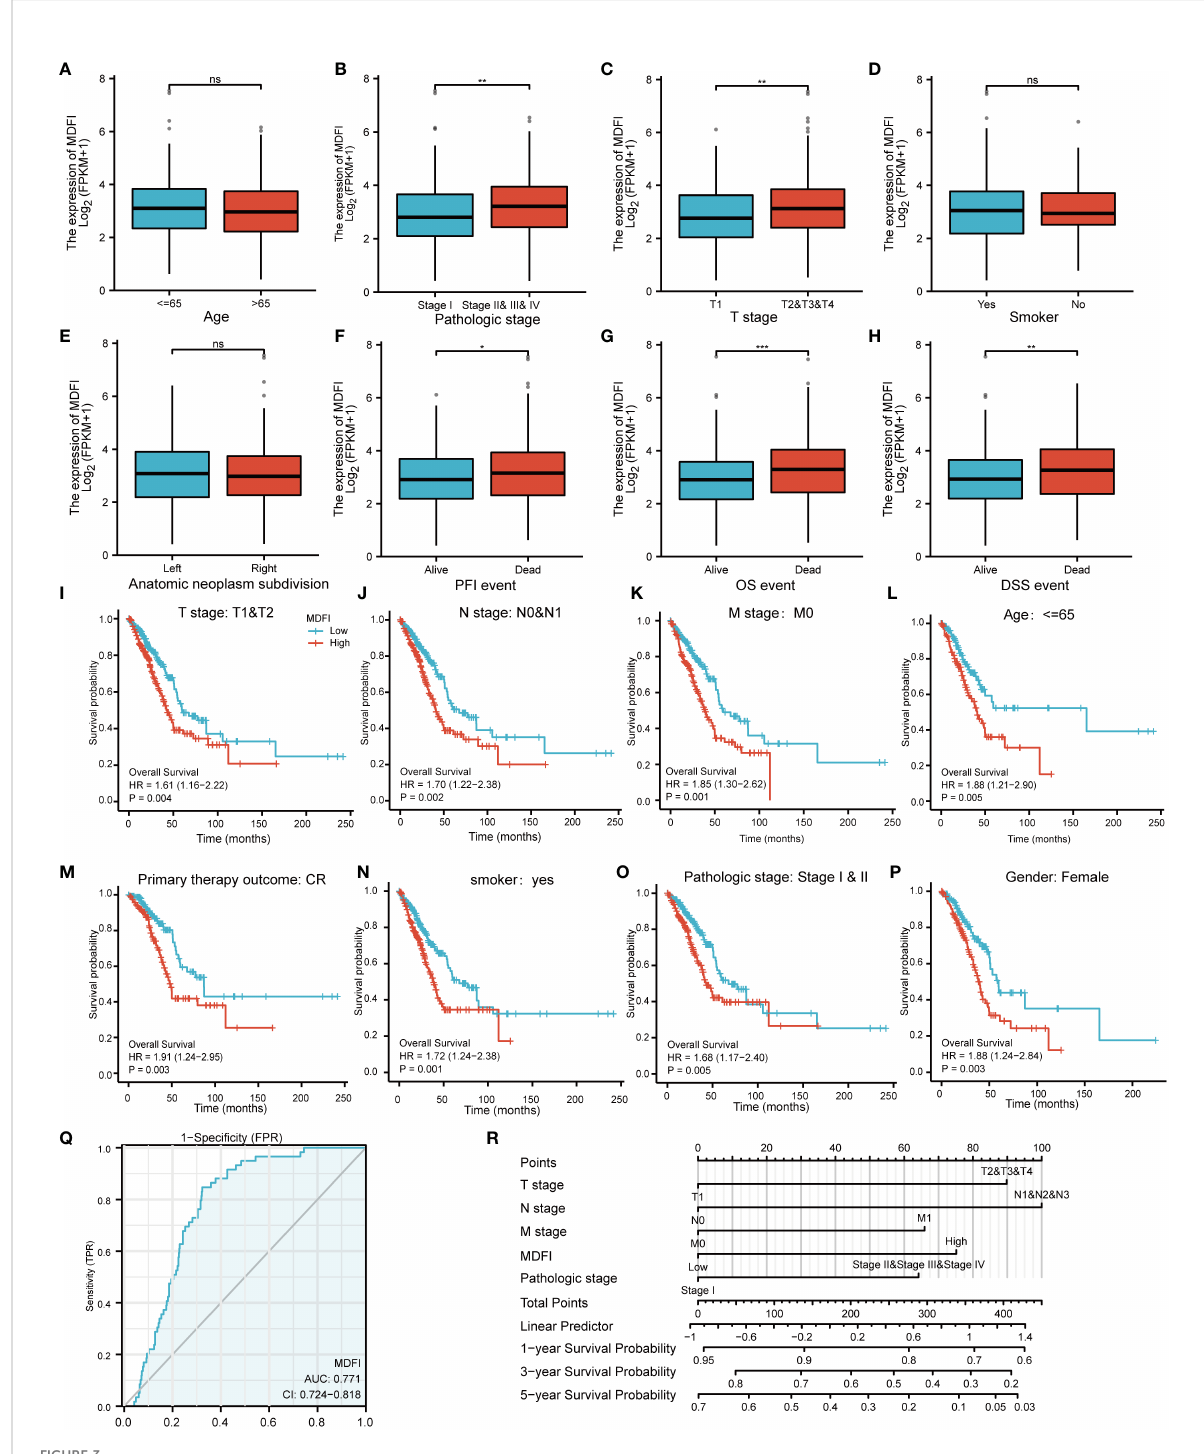
FIGURE 3 Association of MDFI expression with different LUAD characteristics and prognosis, date from TCGA, (A – H) Expression of MDFI in relation to different characteristics of LUAD, (I – P) Association between high MDFI expression in prognosis of LUAD with different characteristics, (Q) MDFI ’ s ROC curve analysis at LUAD, (R) Construction of a nomogram to assess the prognostic value of MDFI in LUAD. *p < 0.05, **p < 0.01, ***p < 0.001, ns, p > 0.05. PFI, Progression Free Interval; OS, Overall Survival; DSS, Diseases-Speci fi c Survival; CR, complete